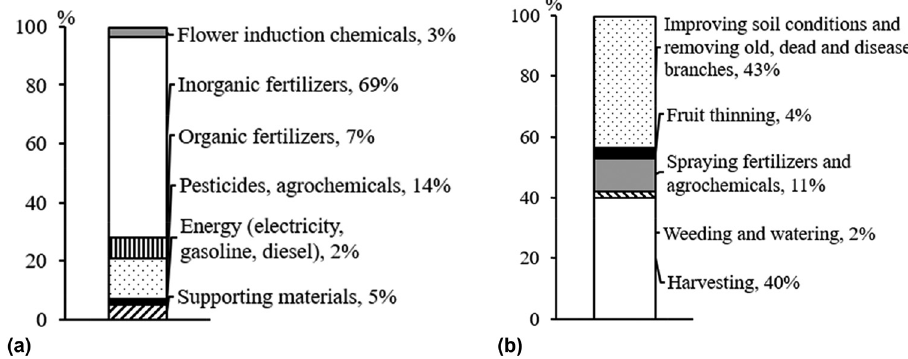
Figure 3: Cost structure of material and labor costs of Idor longan growers in 2019: ( a ) materials costs; ( b ) labor